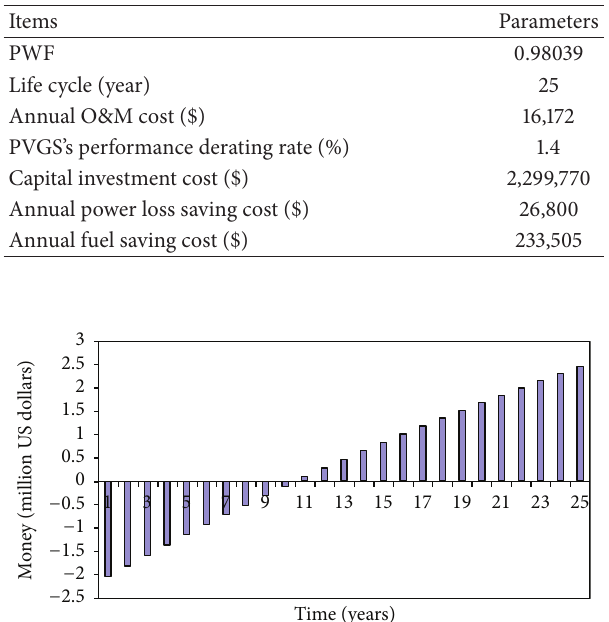
Figure 17: Net present value for installation capacity of 690 kWp